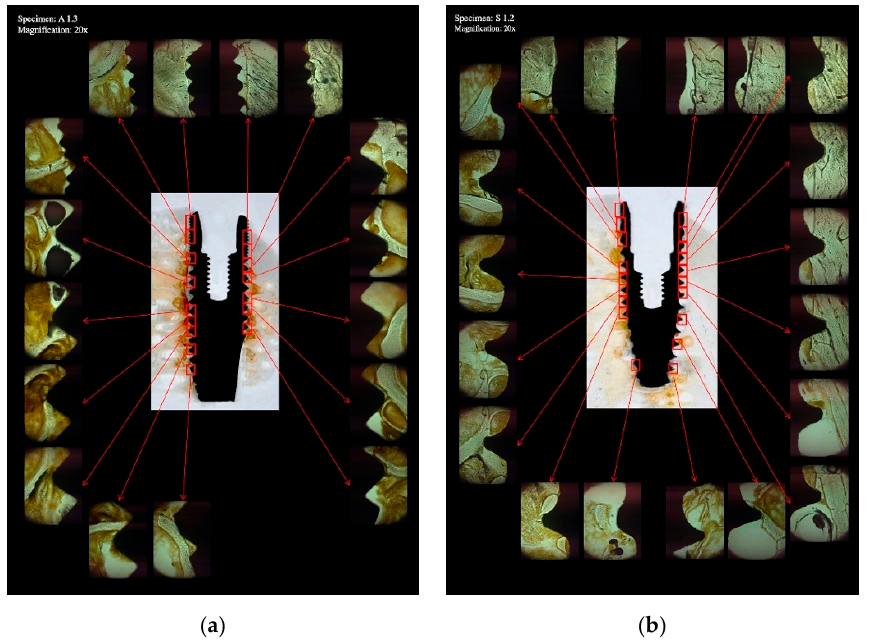
Figure 2. Overview of a histologic section showing an OsseoSpeed ( a ) and a Straumann BLT ( b ) implant placed in bovine rib bone. The implant bone interface was analyzed in varying numbers of images at 20× magnification.